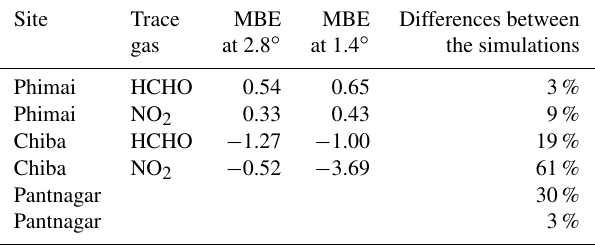
Table 9. The comparison between the observations and simulations at 2.8 and 1.4 ◦ spatial resolutions. The MBE is the mean bias error. The unit of MBE is parts per billion by volume (ppbv). Site Trace MBE MBE Differences between gas at 2.8 ◦ at 1.4 ◦ the simulations